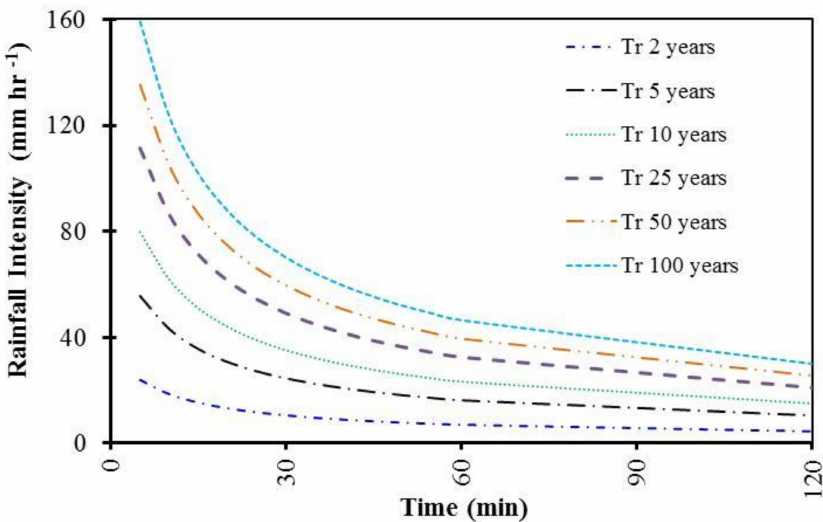
Figure 4. IDF curve for the study area.